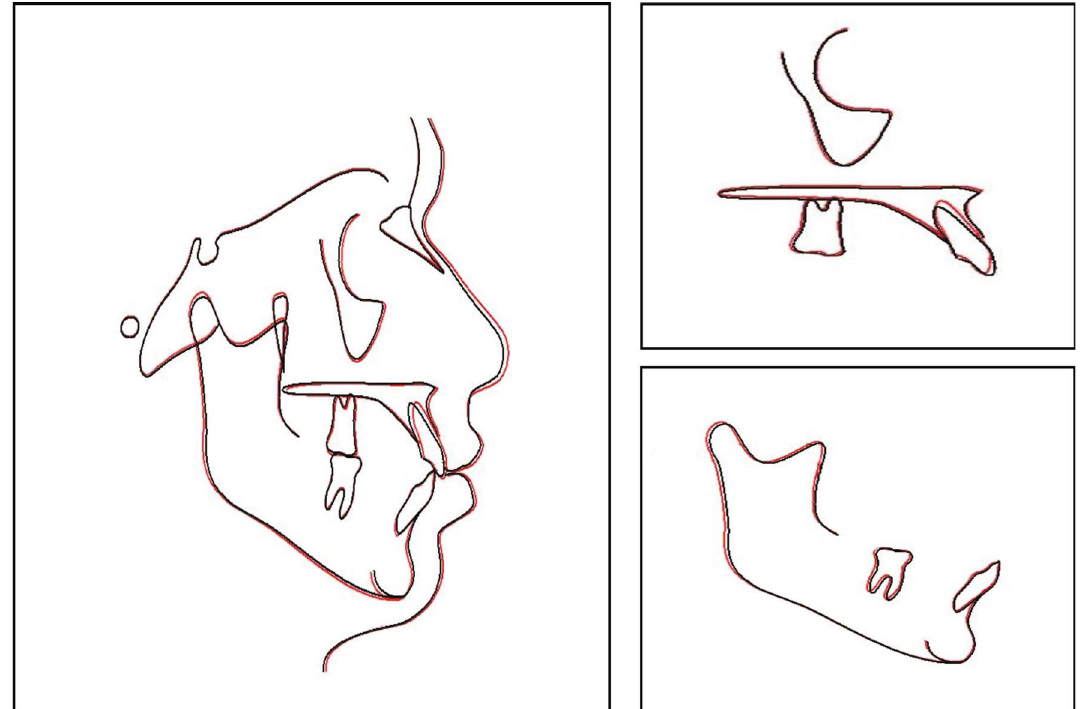
Figure 17: Pre- and posttreatment superimposition.